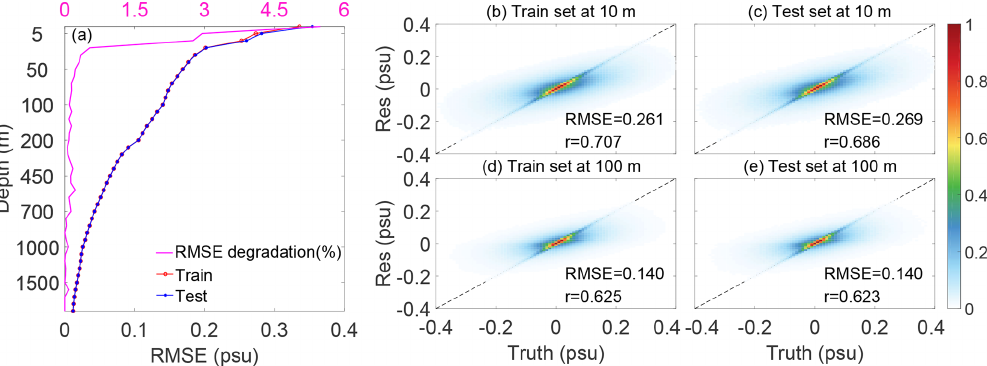
Figure 12. (a) Vertical distribution of RMSE for the training set and testing set for the global region (bottom x axis) and the RMSE degradation from the training set to the testing set (top x axis). (b–e) Density distribution diagrams at depths of 10 and 100m for the training set and testing set, as well as RMSE and correlation coefficients ( r ) for the corresponding layers. The color-coded blocks represent the density of